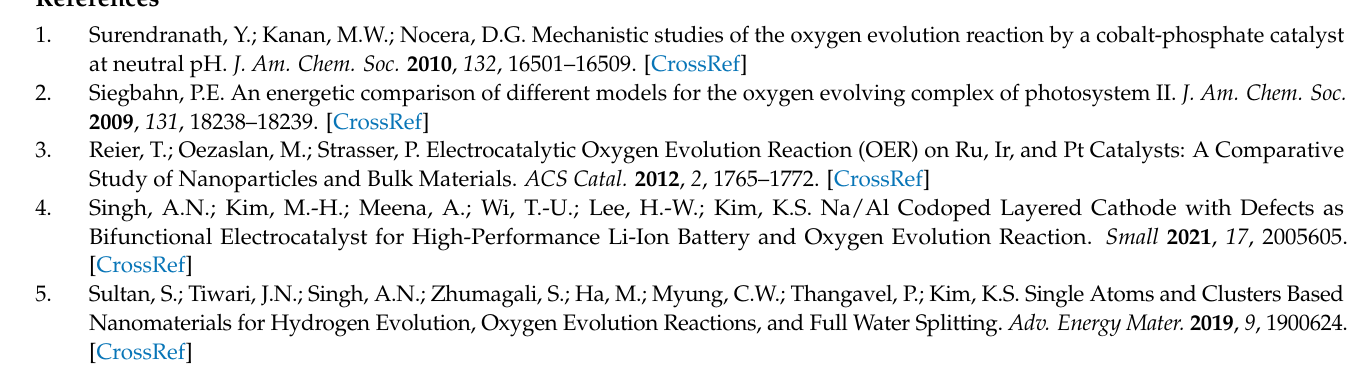
SCO-A; Figure S3: (a) LSV polarization curve of IrO 2 . (b) Tafel plot of IrO 2 ; Figure S4: LSV plot showing OER performances after 1st and 50th CV cycles; Table S1: A comparative chart for overpotential ( η ) of perovskite materials used as OER electrocatalyst; S1: The OER stability data. References [28–30,46–52] are cited in the Supplementary